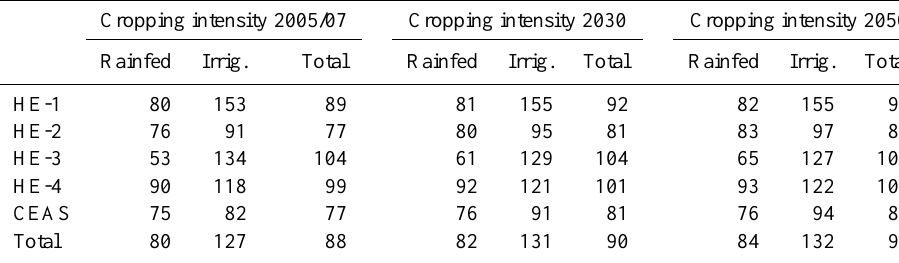
Source: Alexandratos and Bruinsma (2012).